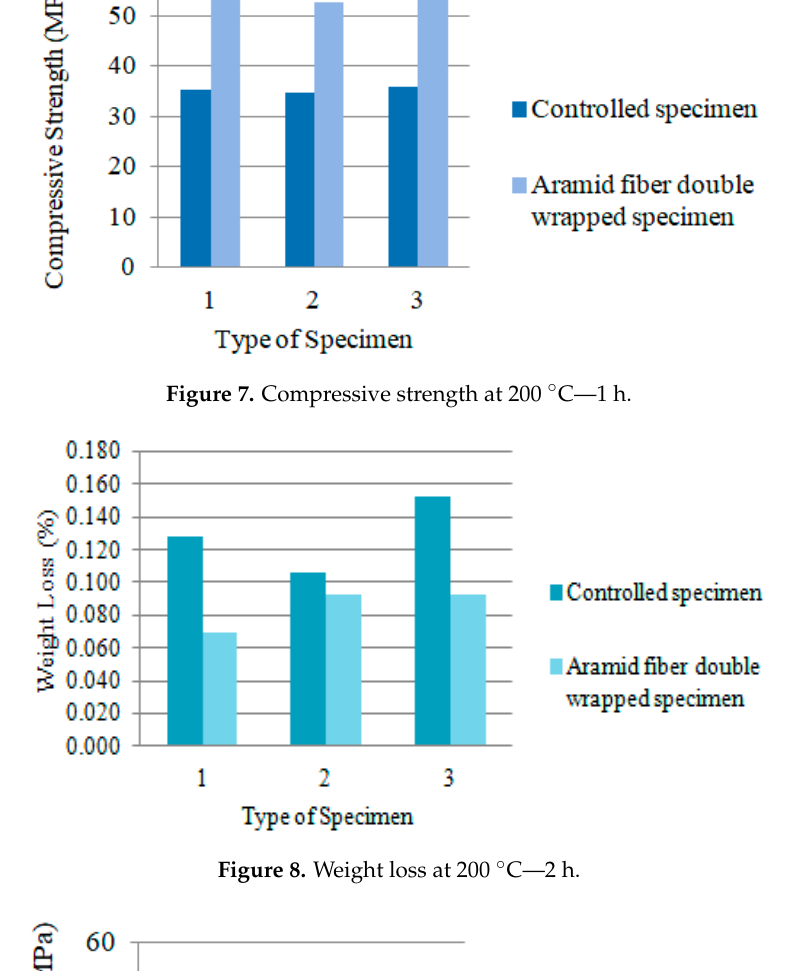
Figure 6. Weight loss at 200 °C—1 h. Table 9. Fire resistance test at 200 °C—2 h. Table 9. Fire resistance test at 200 °C—2 h.